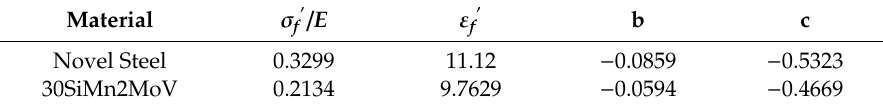
Figure 9. Manson–Co ffi n curves of test materials: ( a ) novel steel and ( b ) 30SiMn2MoV. Figure 9. Manson–Coffin curves of test materials: ( a ) novel steel and ( b ) 30SiMn2MoV. Table 5. LCF parameters of di ff erent Table 5. LCF parameters of different materials.